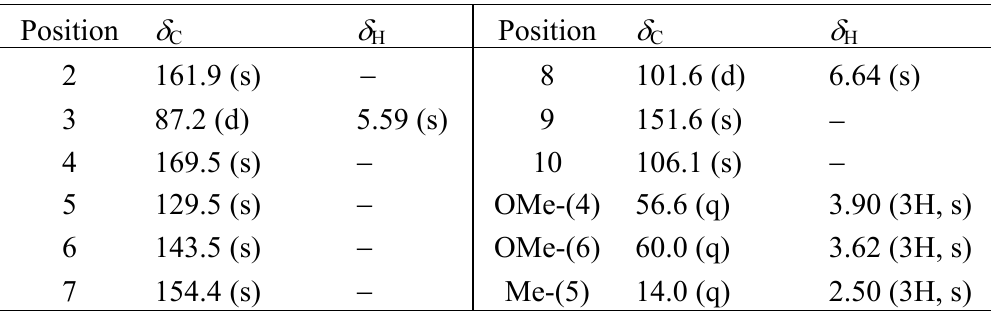
Table 1. The NMR data of 1 (in DMSO-d 6 ).